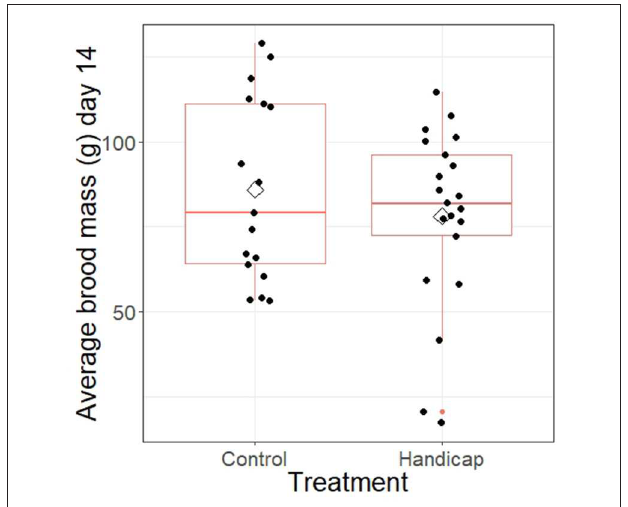
FIGURE 4 | The average brood mass of the nests separated for handicap and control treatment. Boxplot distribution with mean (diamond) and data points are represented. Samples sizes: control n = 17 and handicap n =